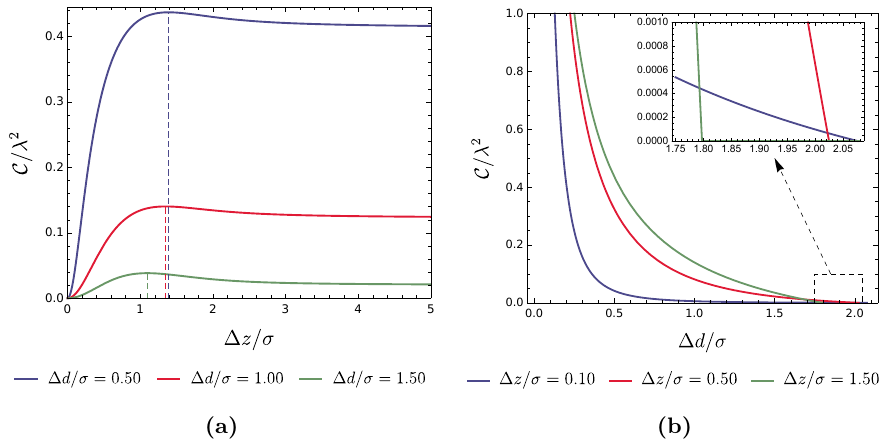
Figure 2. The entanglement harvested by detectors at rest in the presence of a boundary. (a) The concurrence as a function of ∆ z/σ is plotted for ∆ d/σ = { 0 . 50 , 1 . 00 , 1 . 50 } . The dashed line indicates the peak of the concurrence. (b) The concurrence as a function of ∆ d/σ is plotted for ∆ z/σ = { 0 . 10 , 0 . 50 , 1 . 50 } . Here, we have set Ω σ = 0 . 10 . The concurrence C ( ρ AB ) rapidly falls off as the separation ∆ d increases for a fixed distance from the boundary. In the limit of ∆ z → 0 , the concurrence approaches zero.